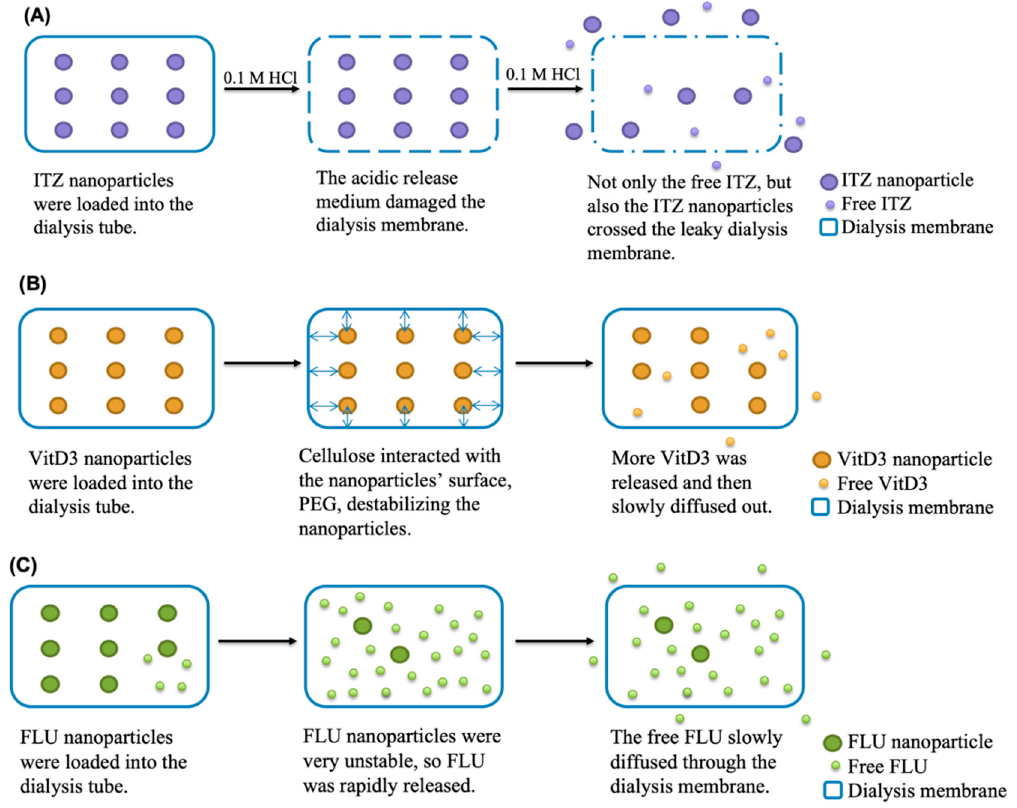
Figure 8. Dominant mechanisms of mis-estimated release kinetics of ( A ) ITZ nanoparticles, ( B ) VitD3 nanoparticles, and ( C ) FLU nanoparticles by the DM method. Table 5. The value of R 2 and exponent (n) for modeling of release kinetics.